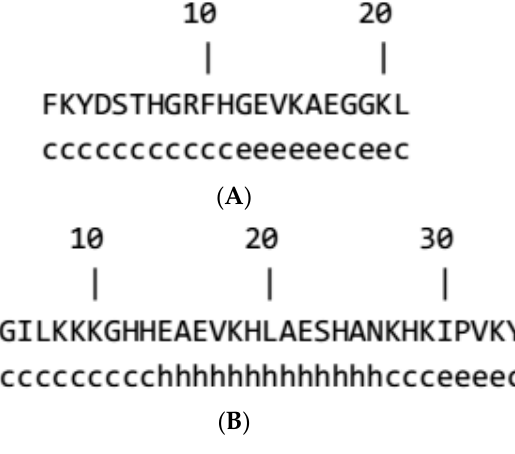
Figure 2. Prediction of the secondary structure of the F21 and B34 isolated in this study. Secondary structures of F21 ( A ) and B34 ( B ) peptides were predicted using the GOR method; c, e, and h represent the secondary structures of random coil, exceeded strand, and helix, respectively.